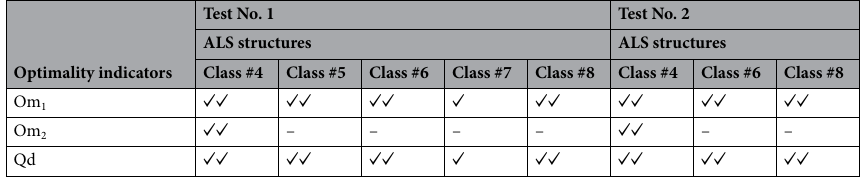
Table 3. Summarized results from tests. ✓✓ —fully satisfied results; ✓ —partially satisfied